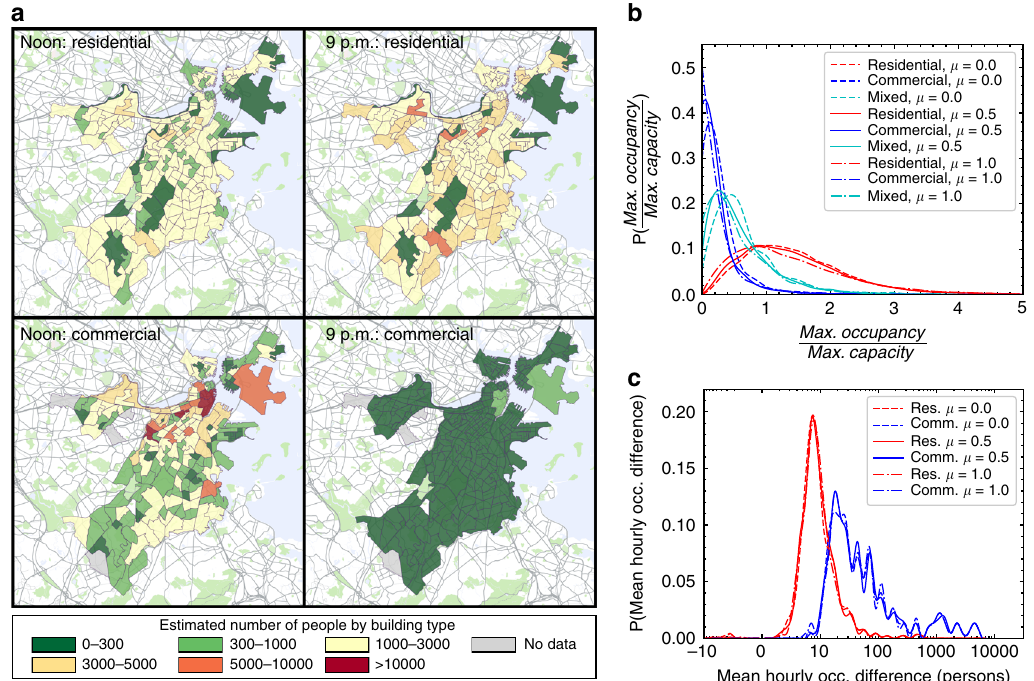
Fig. 4 Building Occupancy results. a Estimated number of building occupants by building type for the mobile-inferred model for residential and commercial buildings. b Distributions of the ratio of maximum observed occupancy to nominal building capacity for ~83,000 buildings in Boston. c Distribution of average hourly occupancy difference between DOE reference and mobile-inferred occupancy for the 1,266 buildings in the energy model. Positive means the DOE occupancy is greater while negative implies the opposite. Maps created using Google Maps, 2019